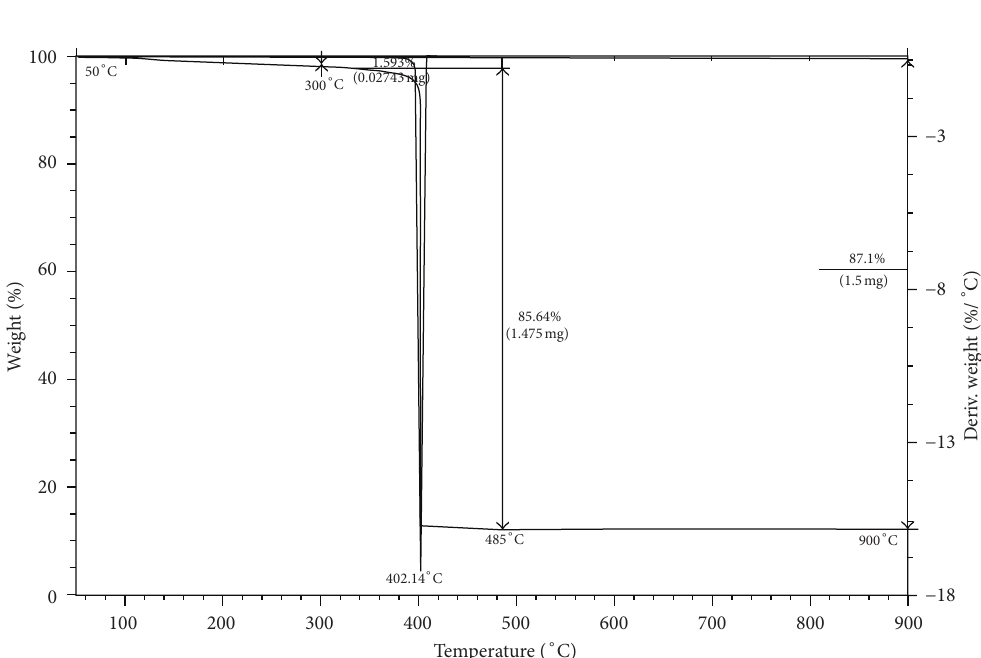
Figure 4: TGA curve of Fc-polyazomethine 6e